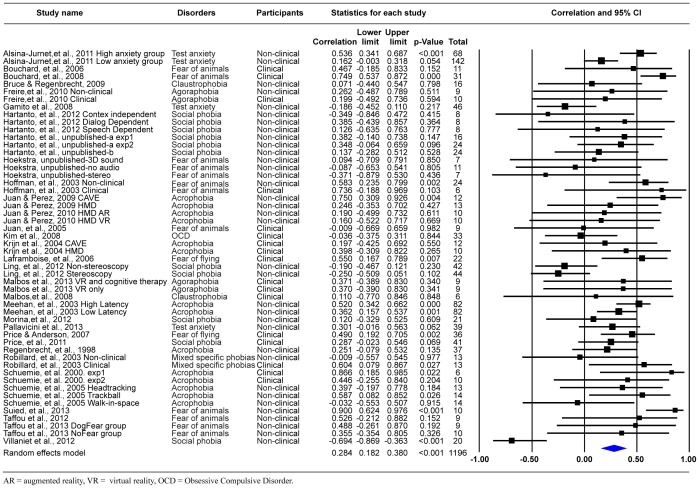
Forest plot of the correlation between presence and anxiety.